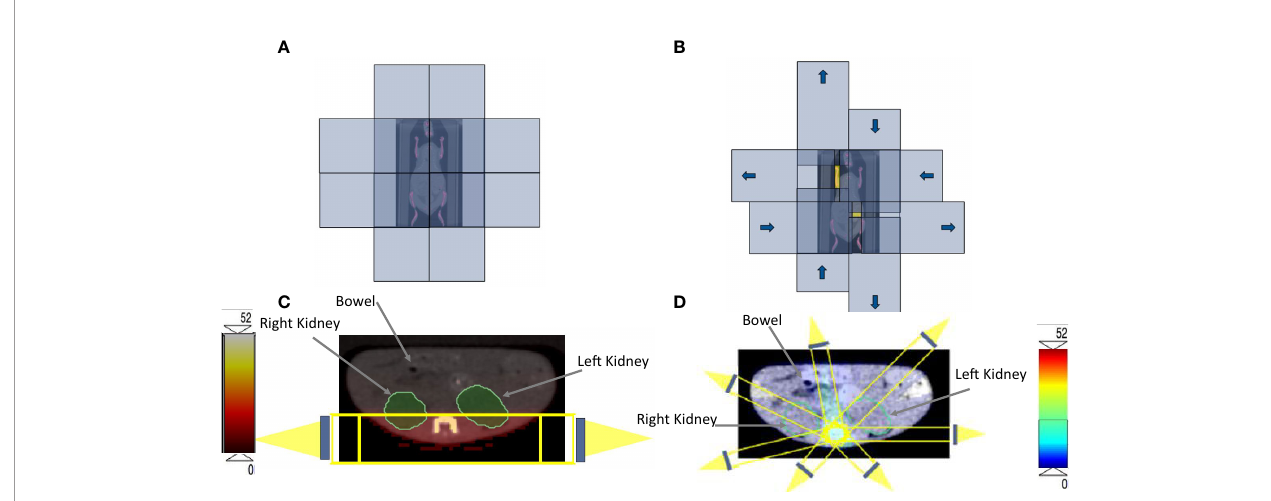
FIGURE 2 | (A) The four orthogonal, double-focused tungsten leaf pairs before the optimization. (B) The four orthogonal, double-focused tungsten leaf pairs after applying the rectangular components to cover the target volume; the yellow color represents the area that beams can go through to the PTV. Identical axial CBCT image at the abdomen level that is showing the kidneys and bowel for both (C) 3D-TMI preclinical model beam arrangements. (D) SOC-TMI schematic beams arrangement according to the X-RAD SmART small animal image-guided irradiation system.